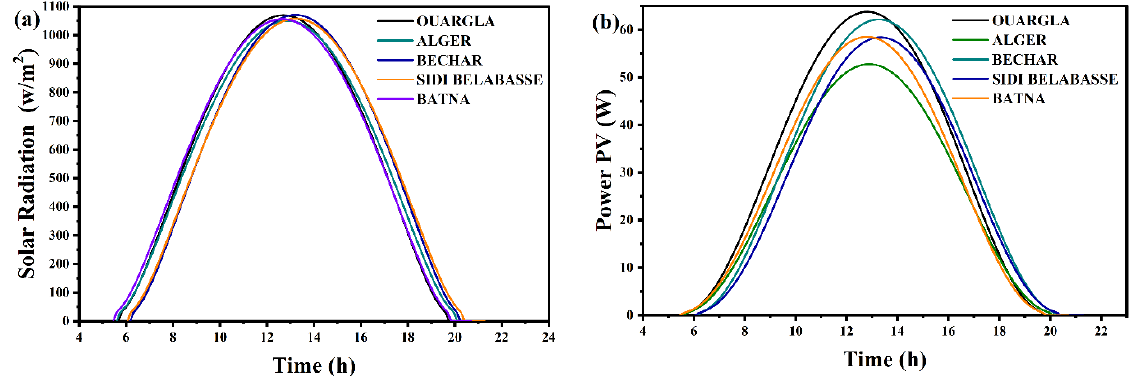
Figure 3. Daily evolution of ( a ) solar radiation and ( b ) power PV at different sites in Algeria (1 July 2022).